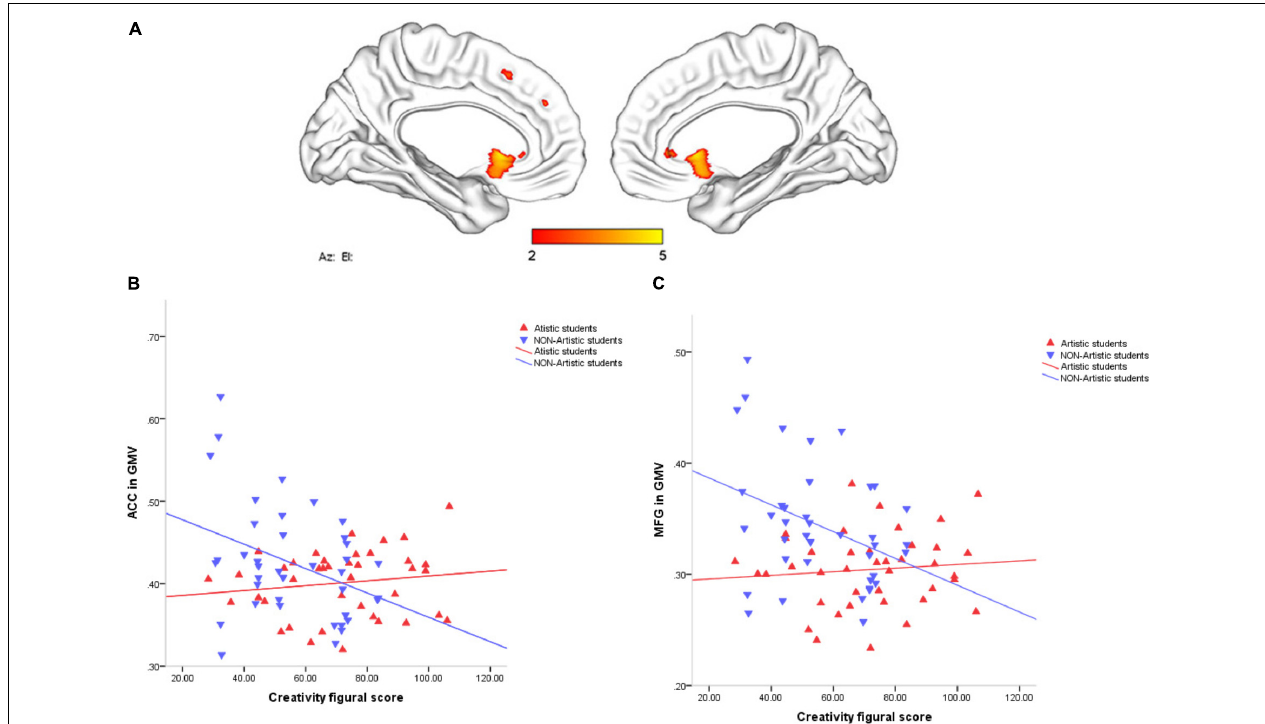
FIGURE 1 | (A) The interaction effect of TTCT-F scores in art majors and non-art majors and the GMVs of the left anterior cingulate cortex (ACC) and left medial frontal gyrus (MFG) (peak voxel MNI coordinate: -2, 18, -2, T = 4.5; -11, 50, 19, T = 4.2), corrected with the non-stationary cluster extent correction (NS) at the whole-brain level. (B , C) Figural creativity scores of the art majors demonstrated a marginal significant positive correlation with the GMVs of the left ACC and MFG ( p > 0.05), whereas a significant negative correlation was observed in the non-art majors ( p < 0.05). TABLE 3 | The interaction effect of brain regions significantly correlated with creativity. Item Clustersize H Peak Tvalue Peak MNI coordinate Brain regions TTCT-F creativity (NS Corrected p < 0.005) 45 L 4.2 − 11 50 19 Medial frontal gyrus 614 L 4.5 − 2 18 − 2 Left cingulate